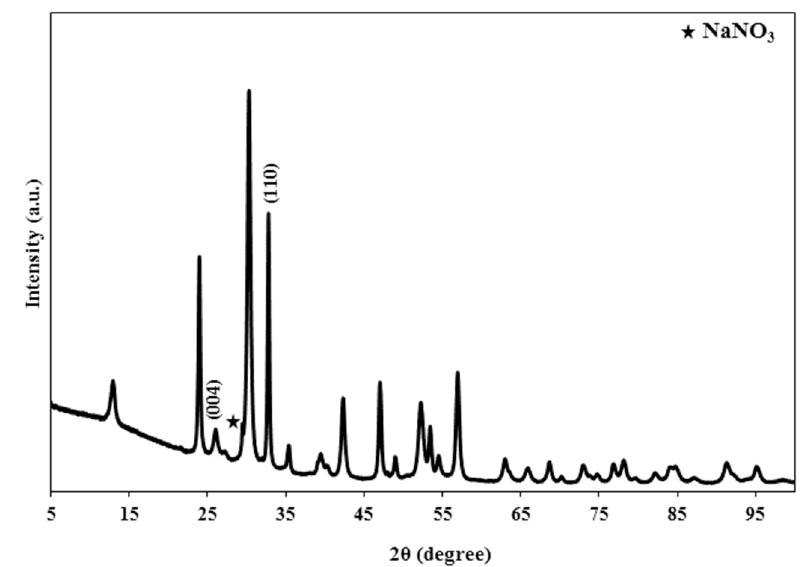
Figure 1. X-ray di ff raction pattern of Bi 2 O 2 CO 3 :Al. Figure 1. X-ray diffraction pattern of Bi 2 O 2 CO 3 :Al. Figure 1. X-ray diffraction pattern of Bi 2 O 2 CO 3 :Al.